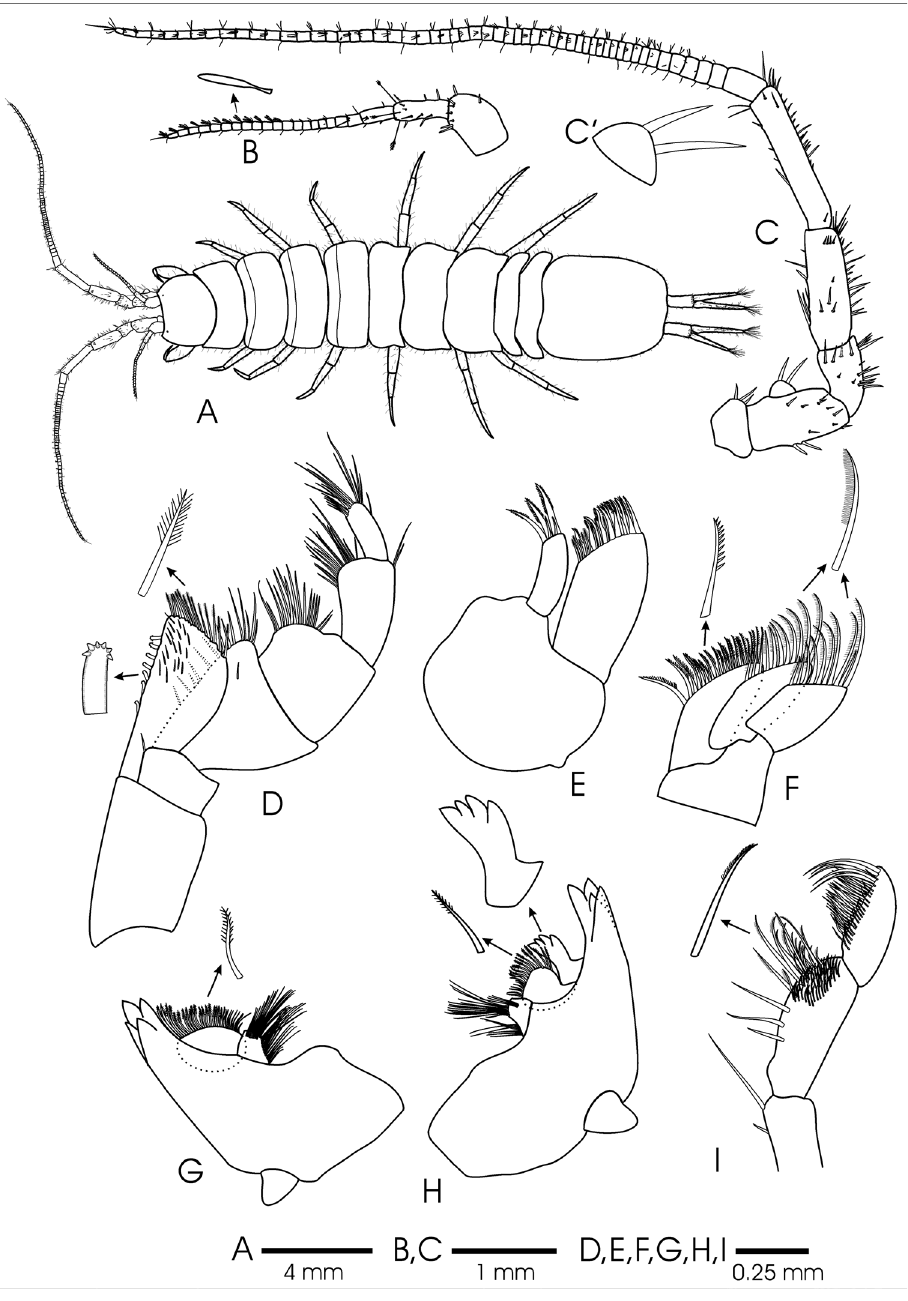
Figure 2. Stenasellus tashanensis sp. n. male. A habitus (dorsal view) B antenna I C antenna II C' squama of antenna II D maxilliped E maxilla I F maxilla II G right mandible H left mandible I mandibular